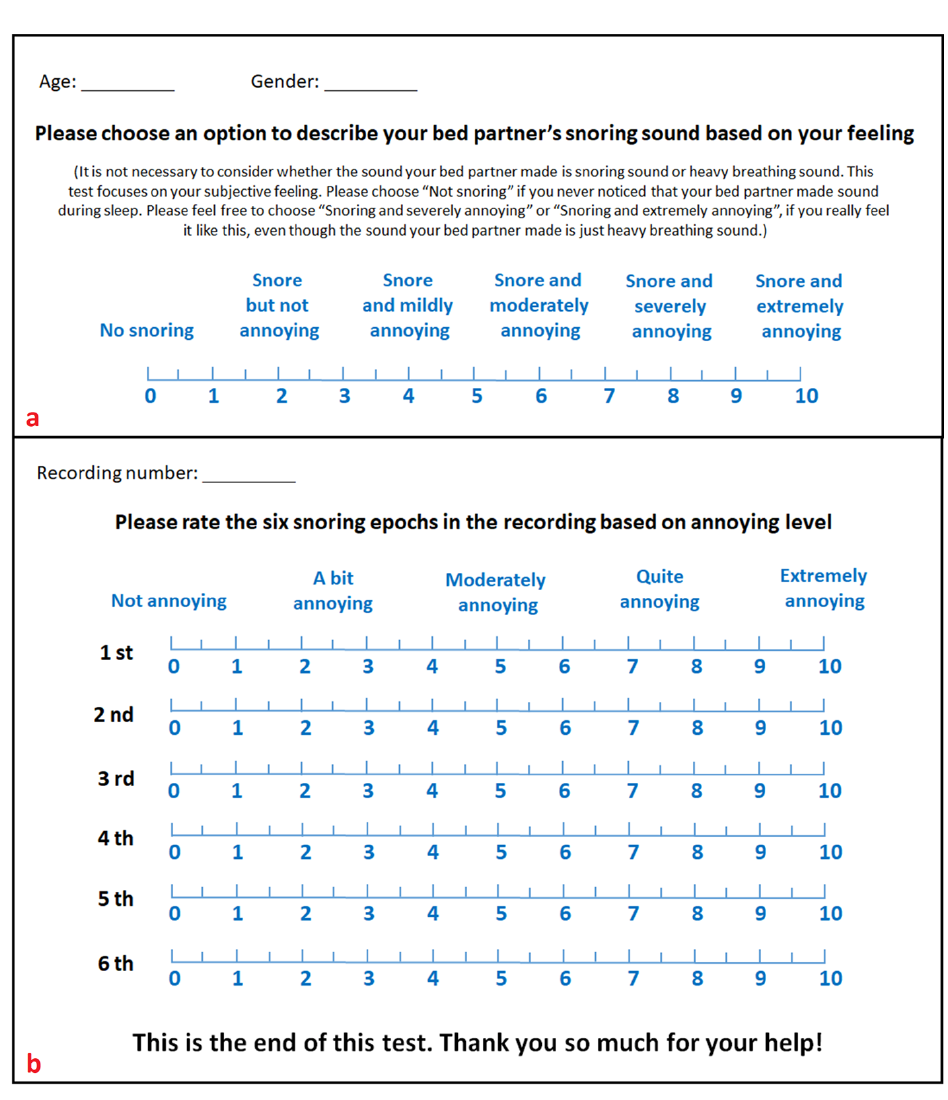
Figure 2. Questionnaire for this study. This questionnaire consisted of two parts, viz., ( a , b ). Part ( a ) was used before the test. Listeners were asked to rate their own bedpartners’ snoring sounds and were divided into different groups based on their answers; Part ( b ) was used for the test. Recording number indicated which of the five audio files with randomly sorted snoring epochs was used for the test. In addition, listeners were asked to score the six snoring epochs: 0 meant not annoying and 10 meant extremely annoying.